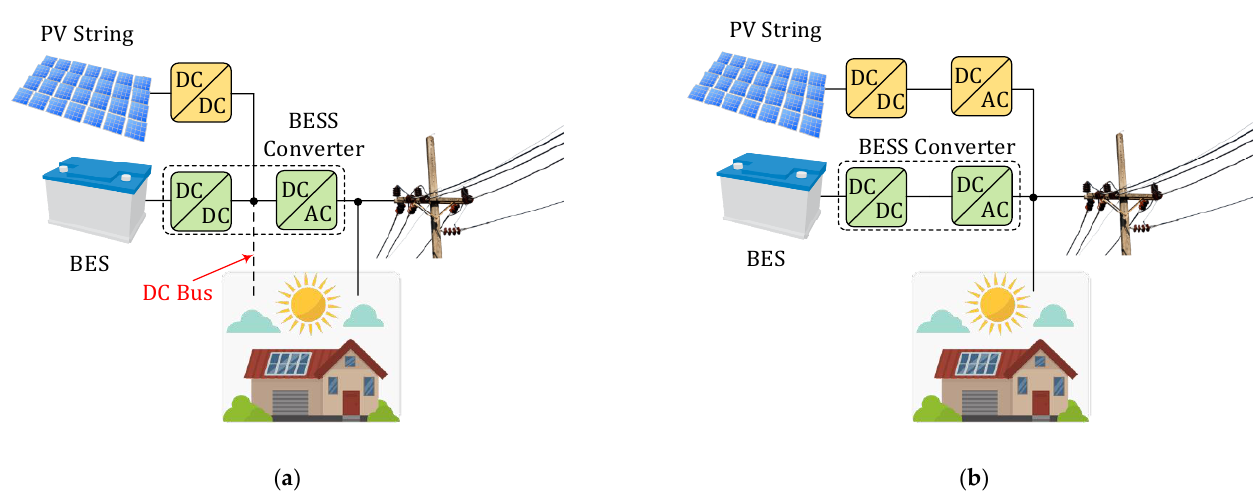
Figure 9. Coupling of units in residential energy systems: ( a ) DC coupling, ( b ) AC coupling.